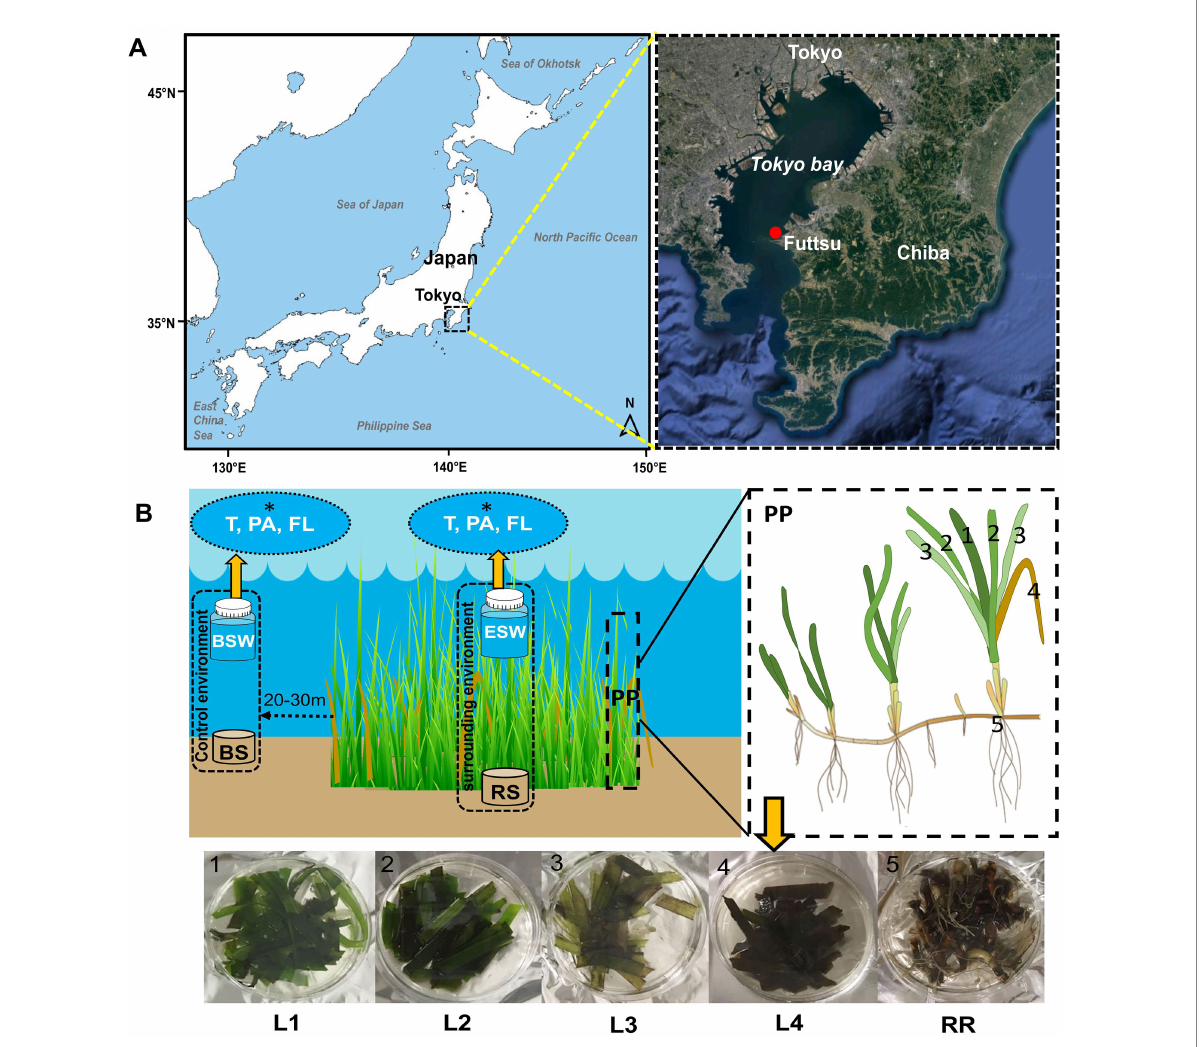
FIGURE 1 Location of the sampling areas and sampling strategy. (A) Samples were collected from Z. marina beds growing at Futtsu clam-digging beach, Chiba Prefecture, Japan, in July and September 2019. (B) At each sampling time, samples were collected from Z. marina plant parts (PP), such as the phyllosphere/leaves (1–4; L1, L2, L3, and L4), rooting zone (5; RR: root-rhizome), and surrounding environments (ESW, eelgrass surrounding water; RS, rhizosphere sediment) and control environment (BSW, bulk seawater; BS, bulk sediment). Within the phyllosphere sample, L1 is considered the youngest leaves, followed by older leaves L2 and L3, whereas L4 is the decayed leaves. Seawater samples were filtered for seawater microenvironment (i.e., T: total (PA + FL); PA, particle-associated; FL, free-living fraction; *white